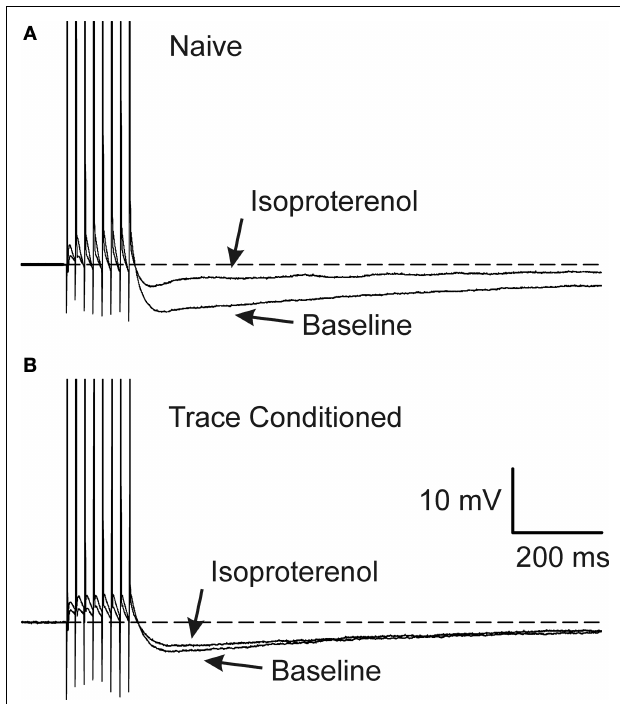
FIGURE 3 | Learning occluded the PKA mediated AHP reduction. Examples of 1µM isoproterenol’s effect on a CA1 neuron from a naïve (A) and a trace EBC (B) rat are illustrated. Note that isoproterenol reduced the postburst AHP without abolishing it in the CA1 neuron from the naïve animal (A) , whereas, isoproterenol had minimal effect on the CA1 neuron from a trained rat (B) . The APs have been truncated for illustration purposes. Reprinted with permission from Oh et al. (2009) © by the National Academy of